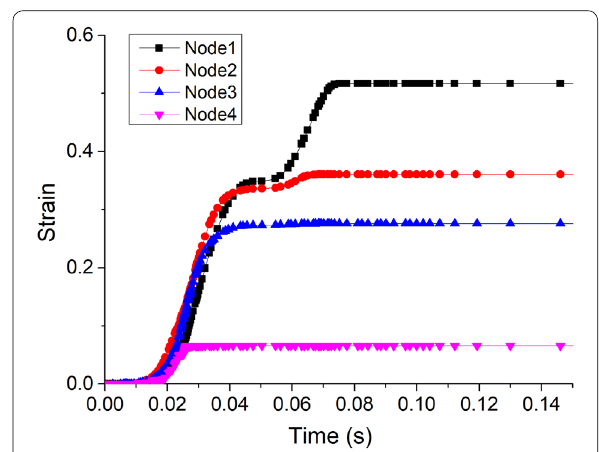
Figure 5 Strain-time curves of nodes from the edge to the center in the radial